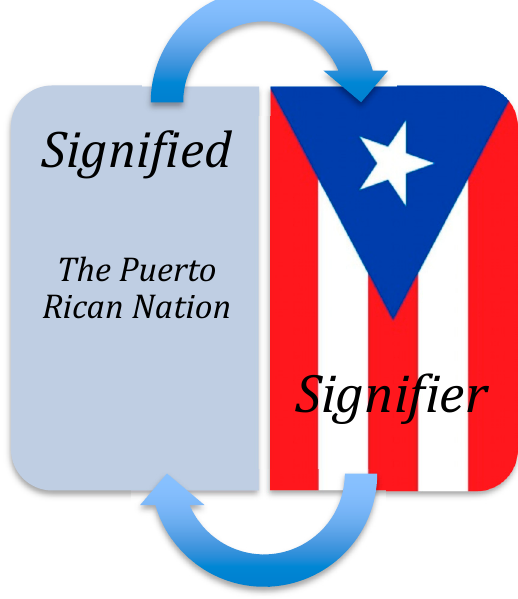
Figure 3. Saussure’s Dyadic System of “signified” and “signifier” as applied by the author